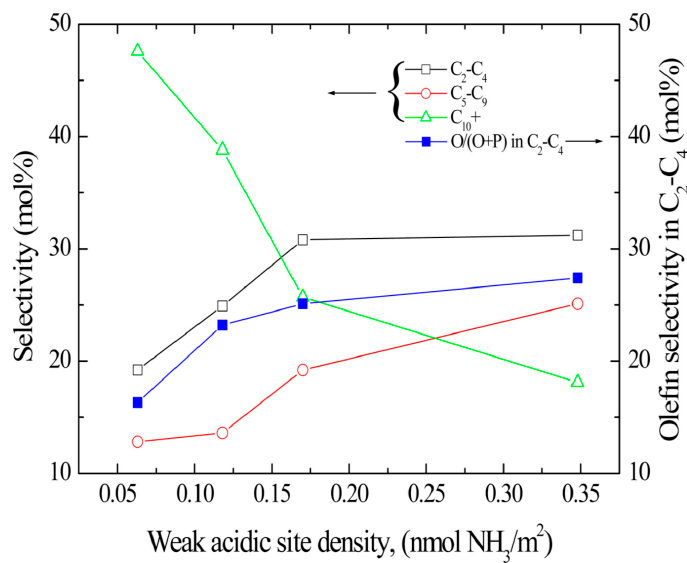
Figure 25. Correlation between the surface acidity and the selectivity of hydrocarbons. Reprinted with permission from [116]. Copyright (2011) Springer, New York, America.